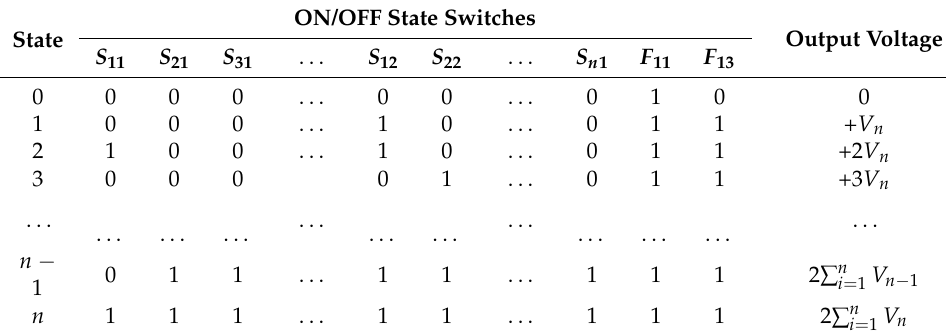
Figure 3. Proposed ADHB multilevel inverter topology. The comparison of the symmetric and asymmetric DHB topologies, in addition to the Table 3. Switching Sequence of the Proposed Asymmetric topologies presented in [13–17], is shown in Figure 4.